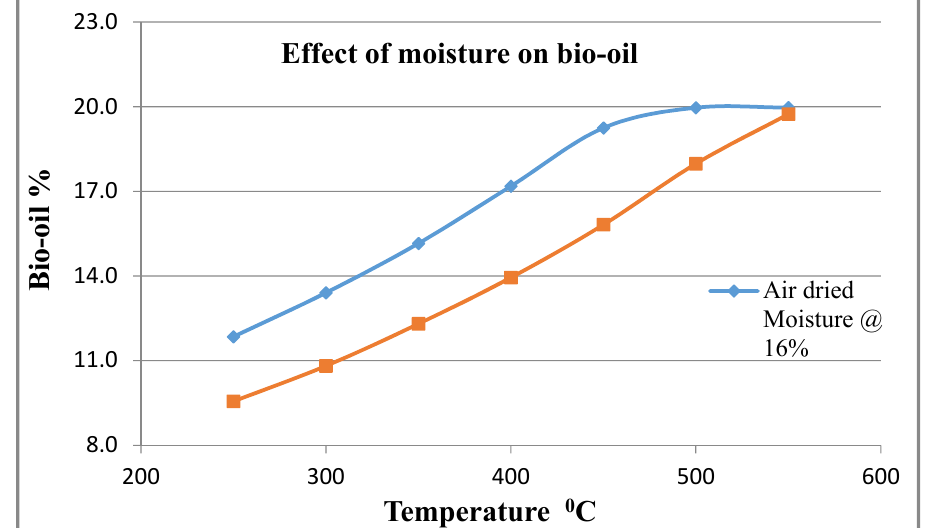
Figure 9. Effect of moisture on bio-oil.